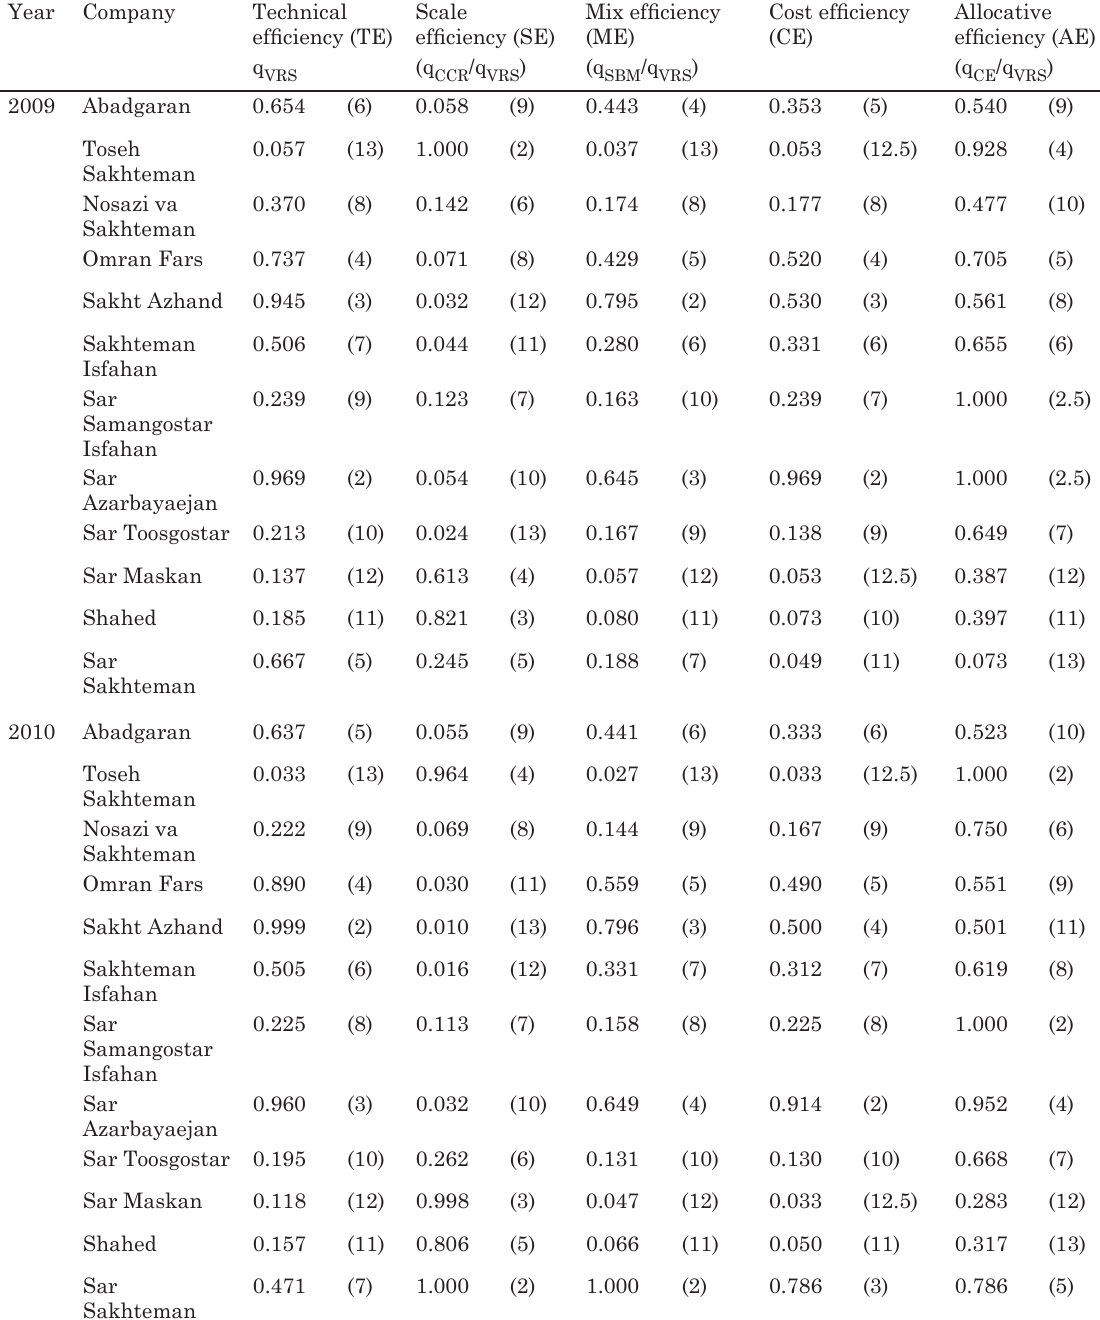
Table 3. Iranian real estate and construction companies DEA efficiency results with virtual company,